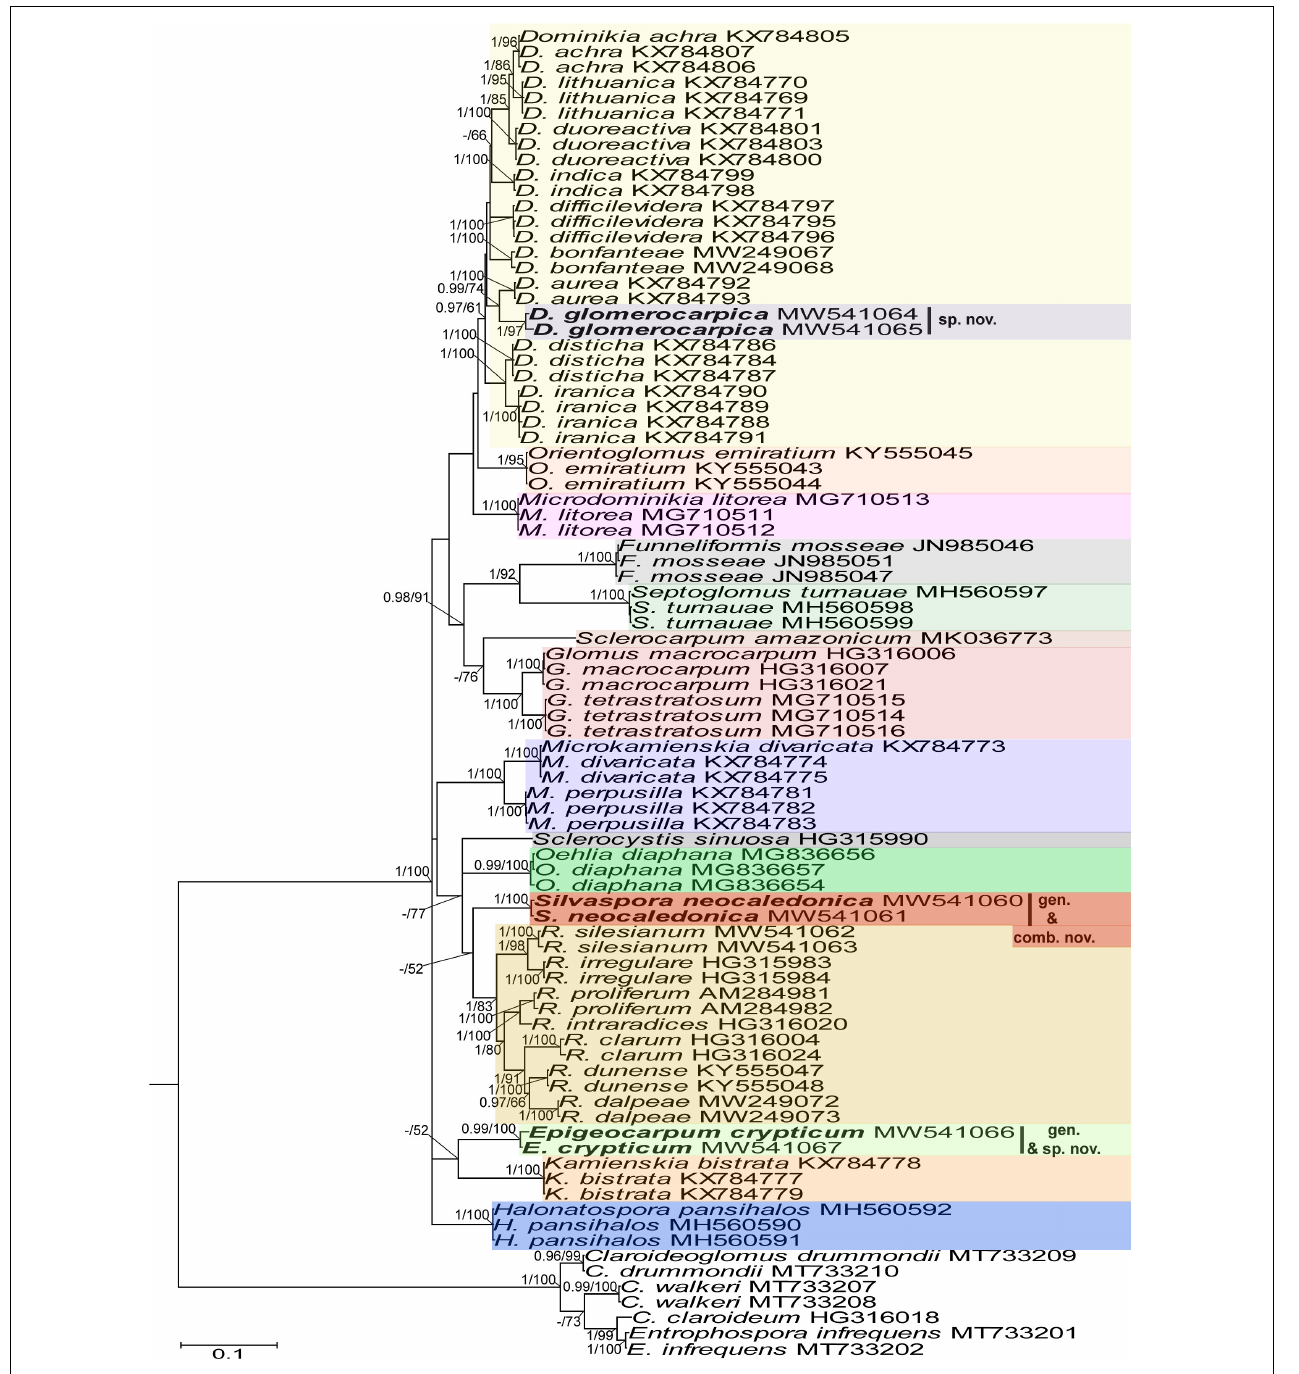
FIGURE 2 | A 50% majority rule consensus phylogram inferred from a Bayesian inference analysis of rpb1 sequences of D. glomerocarpica and E. crypticum , as well as 34 other species of AMF, including C. claroideum , C. drummondii , C. walkerii , and E. infrequens as outgroup. The Bayesian posterior probabilities ≥ 0.90 and ML bootstrap values ≥ 50% are shown near the branches, respectively. Bar indicates 0.1 expected change per site per branch.